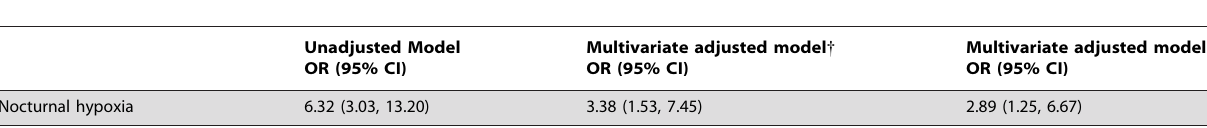
Table 3. Association between nocturnal hypoxia and risk of accelerated loss of kidney